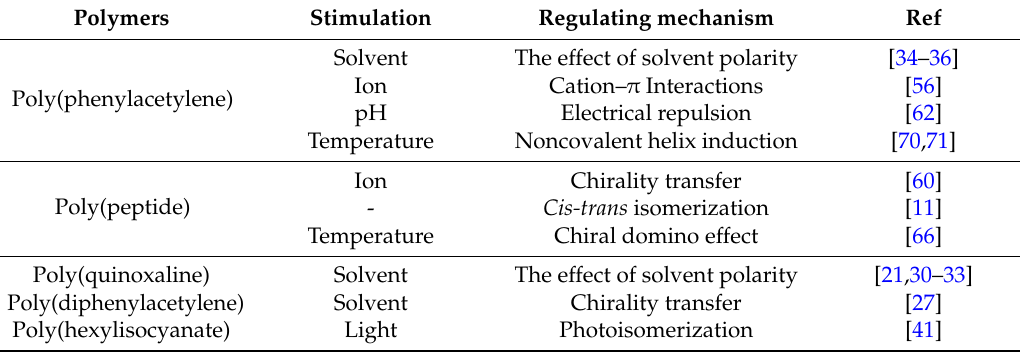
Table 1. Helicity-controllable polymeric systems classified by the category of polymer. Stimulation, regulating mechanism as well as typical references are included.